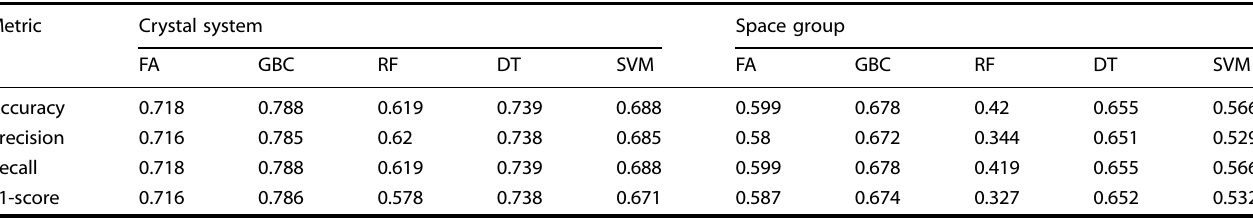
Table 2. LOOCV performance metrics of crystal system and space group classi fi cation. Metric Crystal system Space